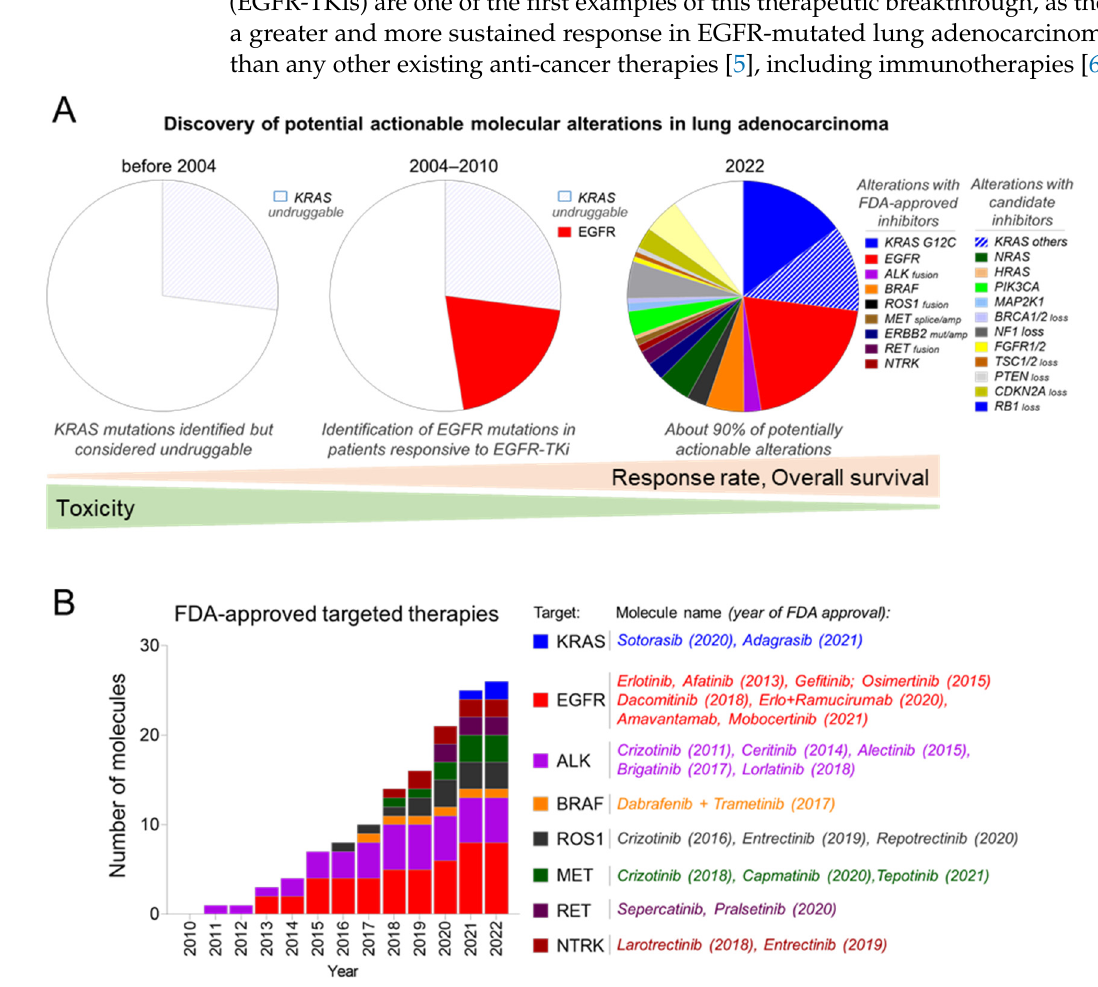
Figure 1. Evolution of identification of actionable alterations and appropriate targeted therapies in the standard of care in advanced non-small-cell lung cancer (NSCLC). ( A ) The discovery of oncogenic drivers in NSCLC led to the development of more personalised medicine and improved response rate and overall survival over the years. ( B ) Increasing number of FDA-approved drugs for treatment of oncogene-addicted NSCLC.